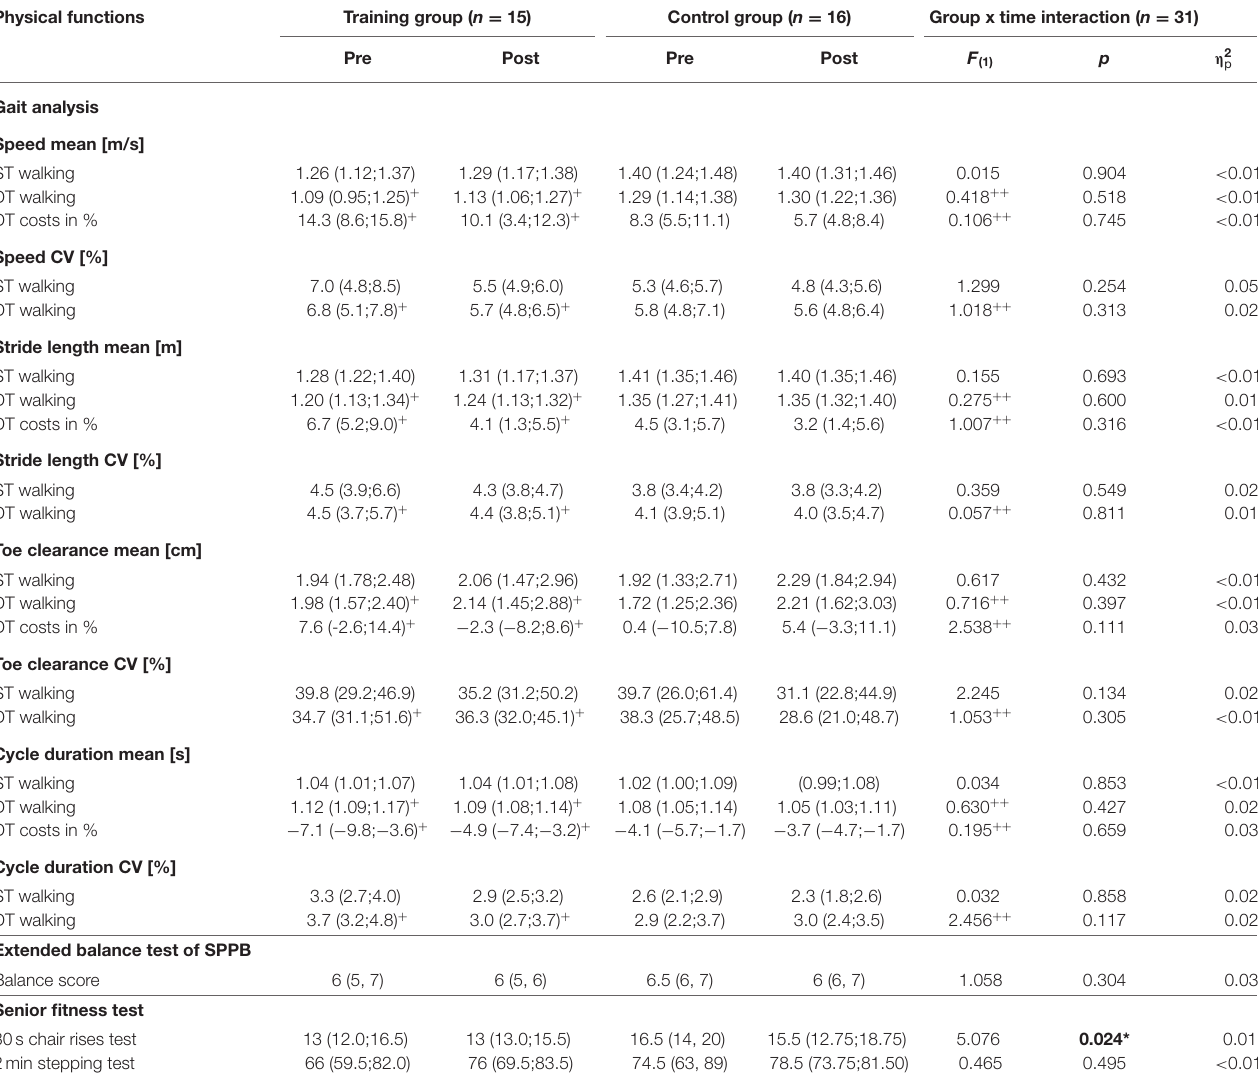
TABLE 2 | Interaction effects (group x time) in physical